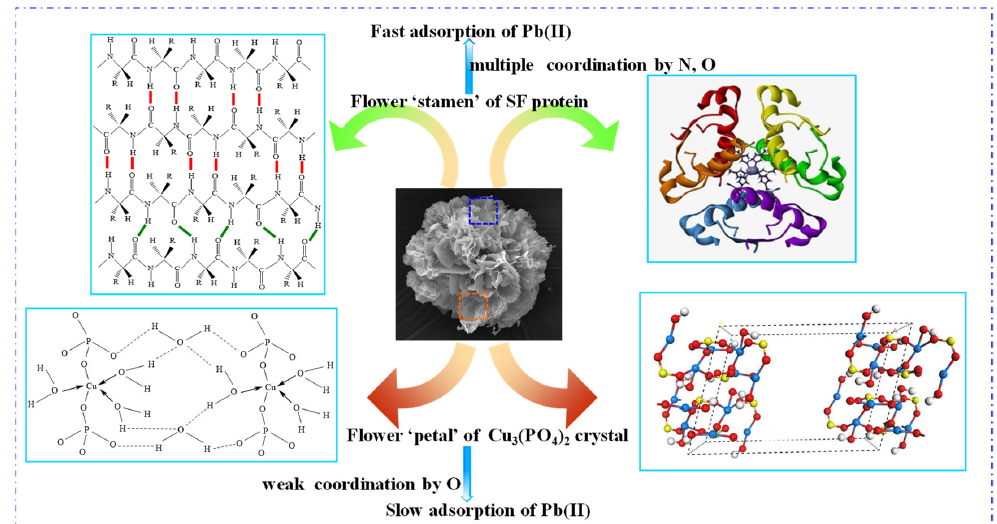
Figure 10. Proposed adsorption mechanism of Pb(II) by SF@Cu ‐ NFs. Upper part indicates the fast adsorption of Pb(II) by the organic SF component and lower part indicates the slow adsorption of Pb(II) by the inorganic Cu 3 (PO 4 ) 2 component.